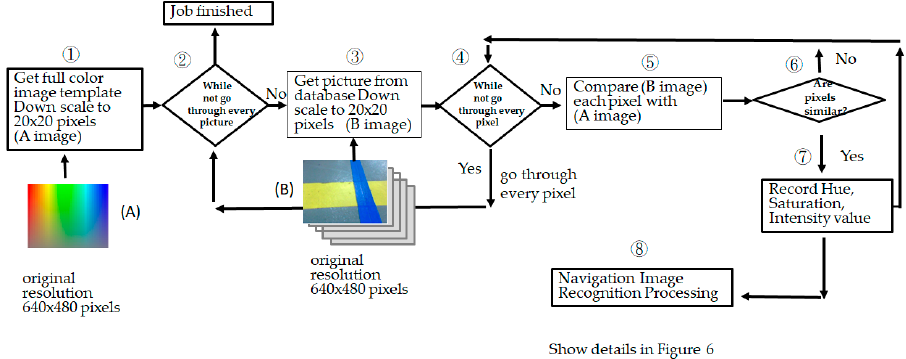
Figure 5. Machine learning image recognition analysis process block diagram. Details of the naviga- tion image recognition process is shown in Figure